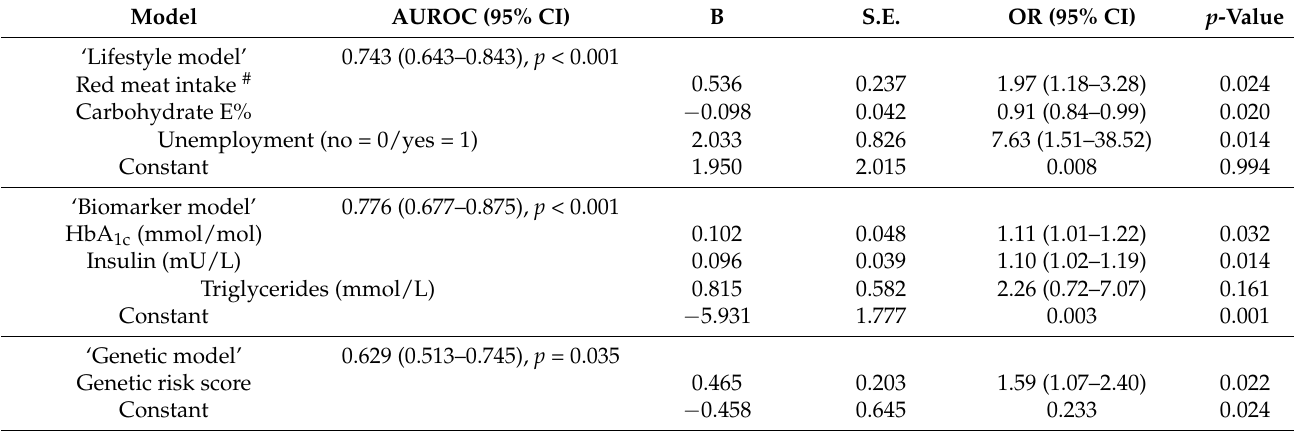
Table 3. Multivariable logistic regression models to predict